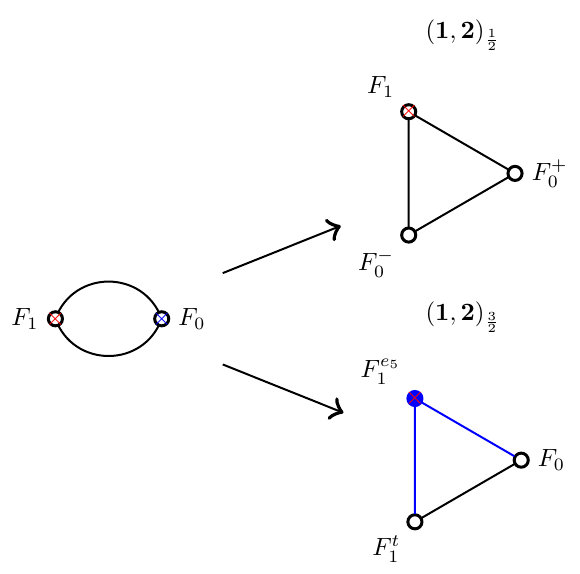
Figure 2 . Schematic depiction of the degeneration of the I 2 Kodaira fibers over the codimension- two loci corresponding to local matter transforming in the representations ( 1 , 2 ) ∆ = 0 ) and ( 1 , 2 ) (over d = s = 0 ). Note that a blue (respectively, red) × in the center 0 e 1 2 ( a ) 3 / 2 of a node corresponding to an irreducible P 1 component of the singular elliptic fiber indicates that ˆ ˆ D 0 (respectively, D 1 ) intersects the said P 1 in a point. The blue node is wrapped entirely by